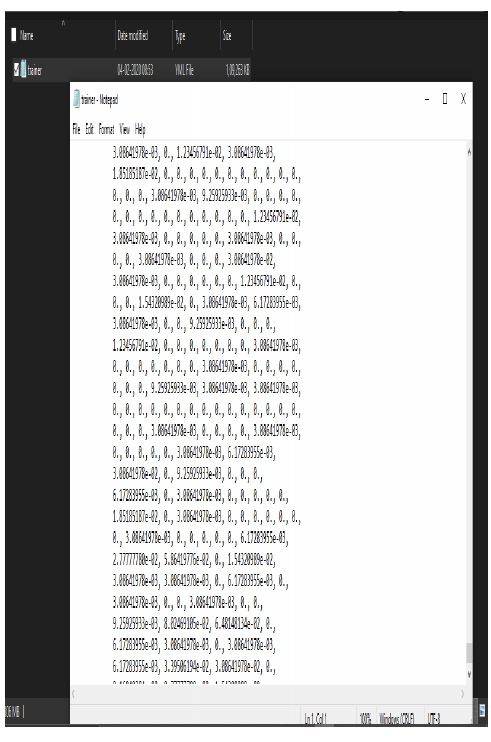
Figure 3. Trained values of the data-set.